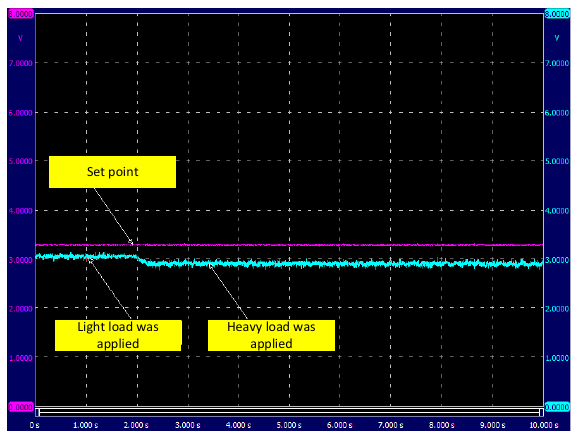
Fig. 4. Tachometer signal under light and heavy